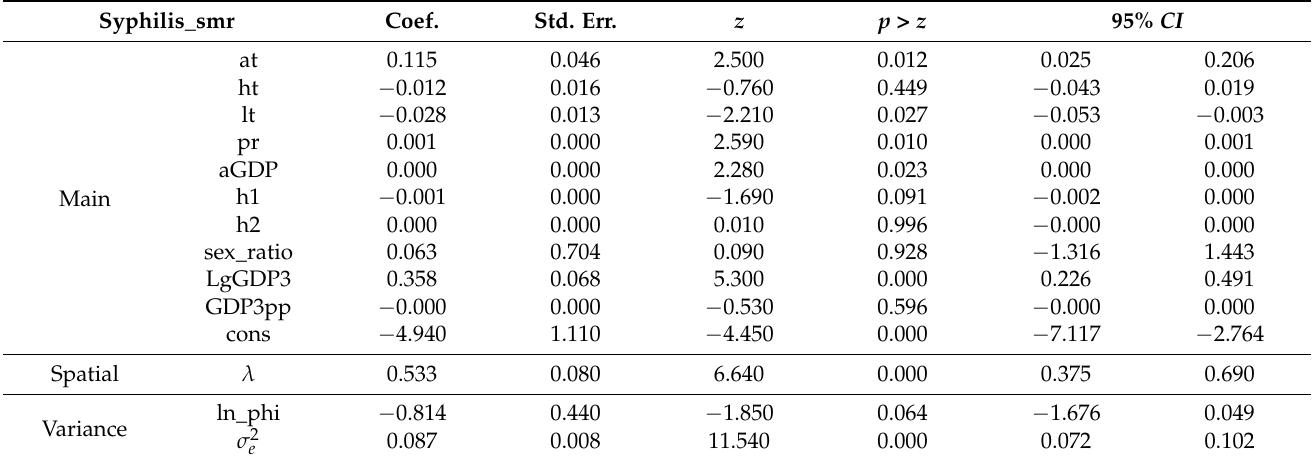
Table 5. HAUSMAN test.